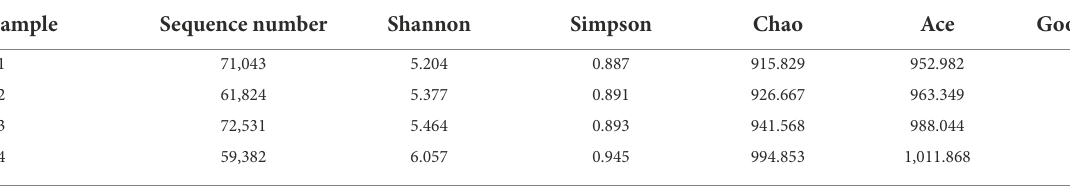
TABLE 2 Alpha diversity indexes of microbial community in each sampling site.